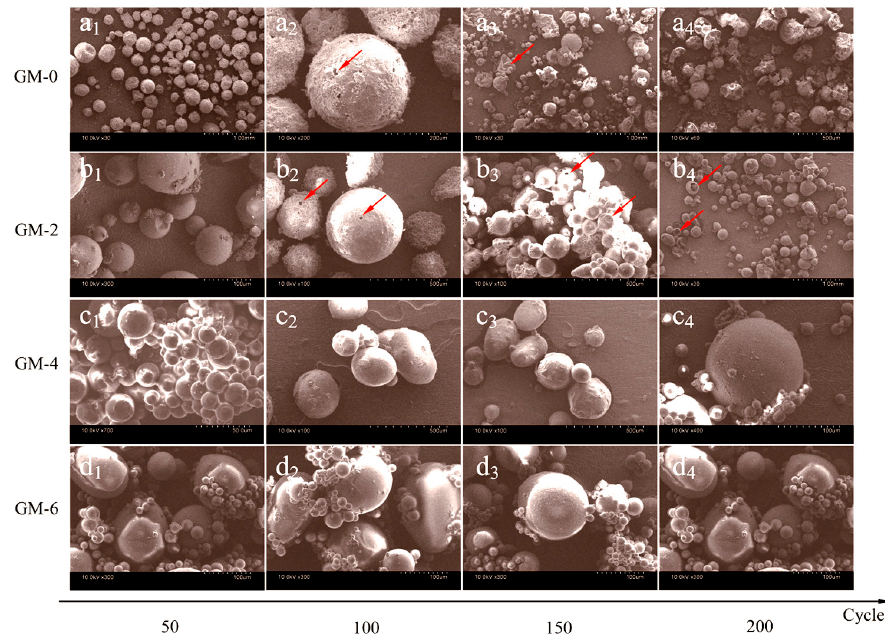
Figure 11. SEM morphologies of microPCMs samples (MG-0, MG-2, MG-4, and MG-6) with various heat absorbing-releasing cycles (50, 100, 150, and 200 cycles): ( a 1 – a 4 ) MG-0; ( b 1 – b 4 ) MG-2; ( c 1 – c 4 ) MG-4; and ( d 1 – d 4 ) MG-6.